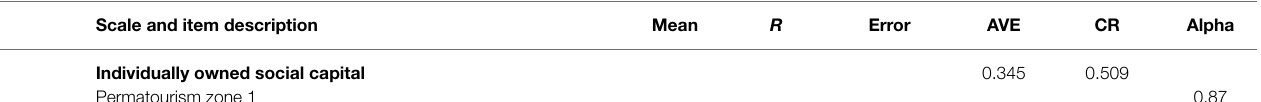
TABLE 2 | CFA of complete measurement